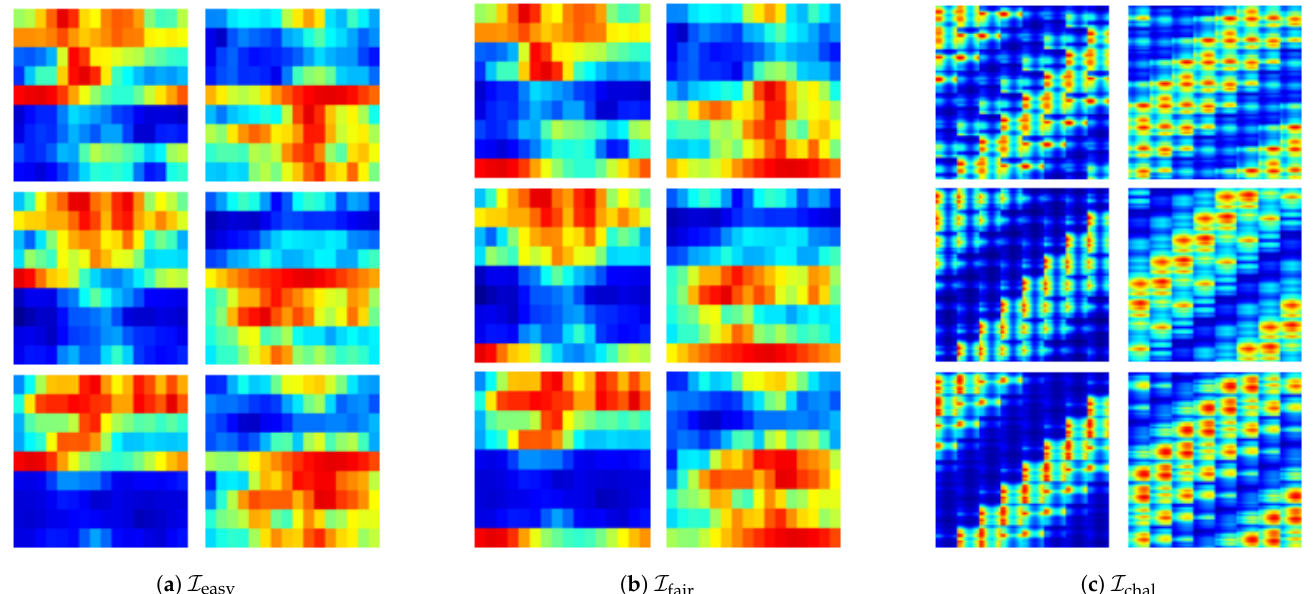
Figure 4. The selected examples of produced I easy , I fair , and I chal : For all ( a – c ), a pair of figures represents dumbbell curl ( left ) versus dumbbell kickback ( right ). For ( a ), it is easy to see that the left and the right figures can be featured based on upper and lower stripes of the heat map. From ( b ), stripe pattern in the left figure is separated at top and bottom; nevertheless, the two figures can be fairly featured with stripe patterns. In ( c ), the two figures show the opposite diagonal patterns against each other. The pattern seems like periodic but becomes challenging to be featured in a simple